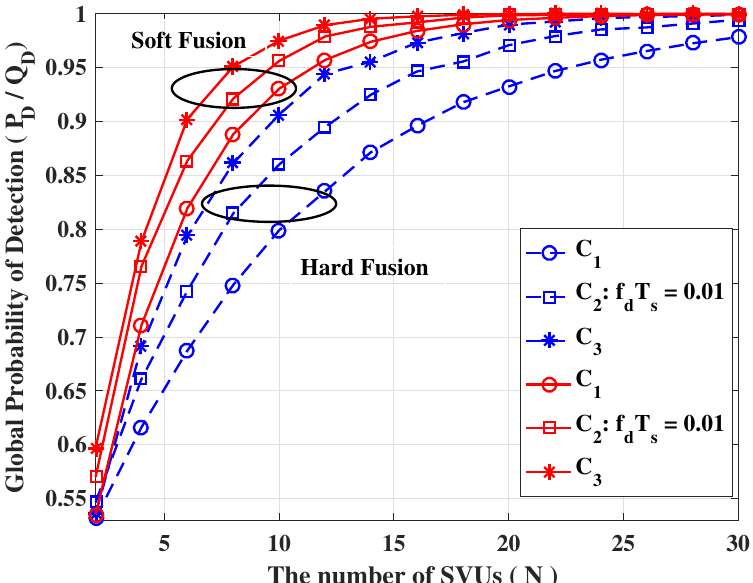
Figure 10. The detection probability of cooperative sensing for various number of SVUs ( K = 50, η 0 = − 8 dB, P = F / Q F